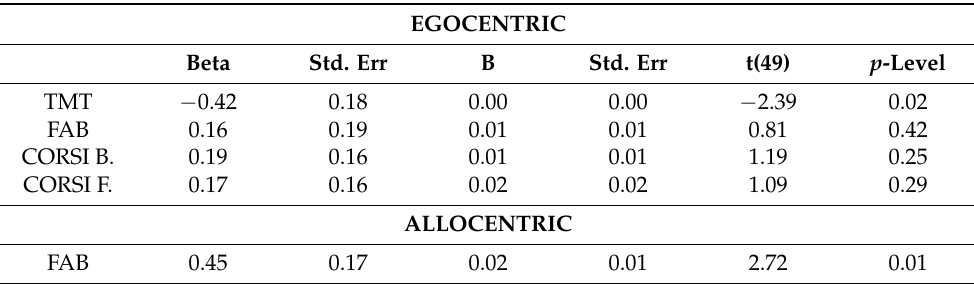
Table 5. The upper part of the table shows the relationship between NC group’s performance at TMT, FAB, Corsi Backward and Forward and accuracy of Egocentric judgments; the lower part of the table shows the relationship between participants’ performance at FAB and accuracy of allocentric judgments. The multiple regression parameters are